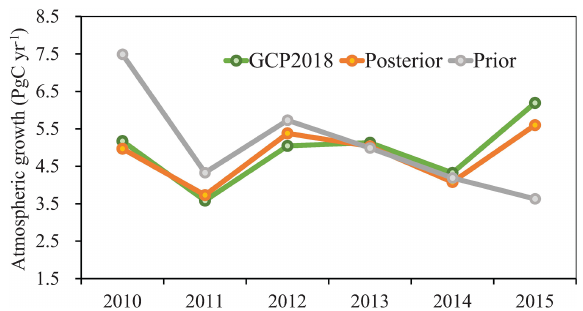
Figure 9. Interannual variations in the atmospheric CO 2 growth